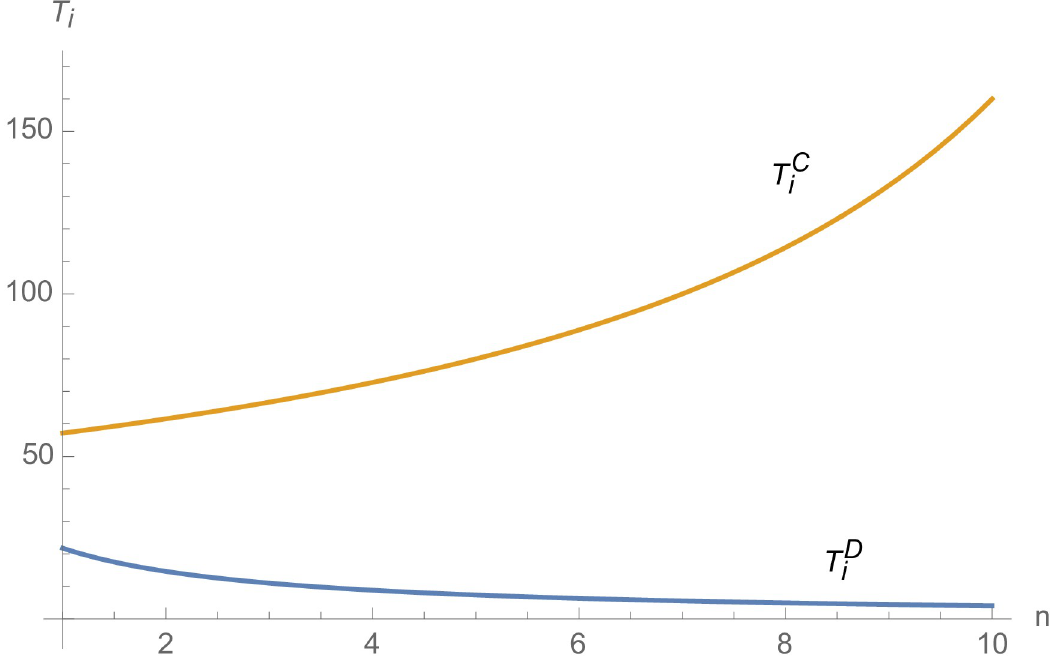
Fig 30. The impact of n on T